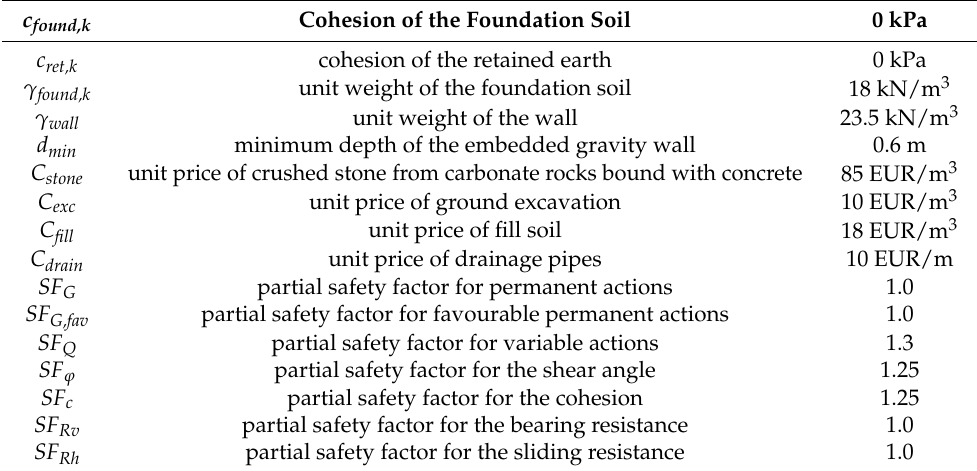
Table 2. Input data for the optimization